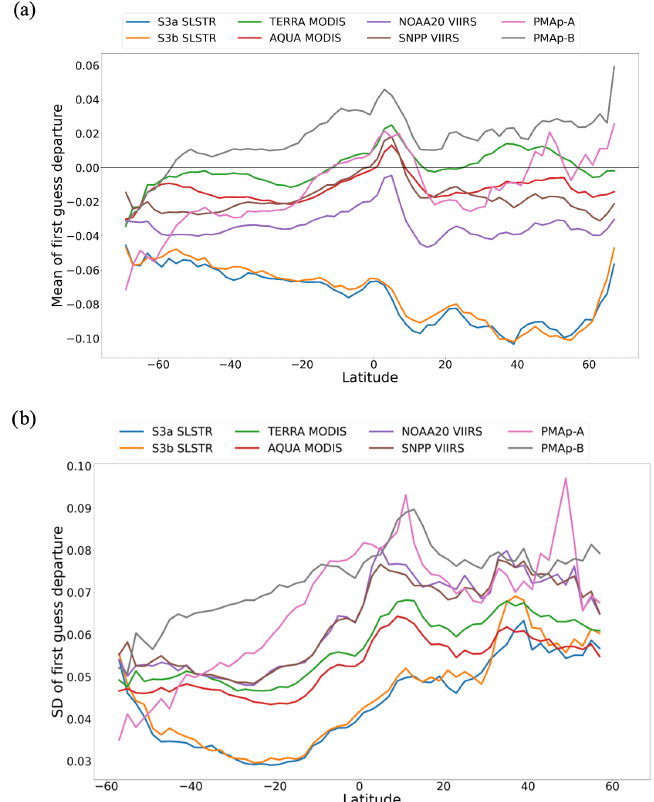
Figure D5. Latitude cross-section of the mean (a) and SD (b) of the first-guess departure for the MAM (2019–2020) period over ocean.